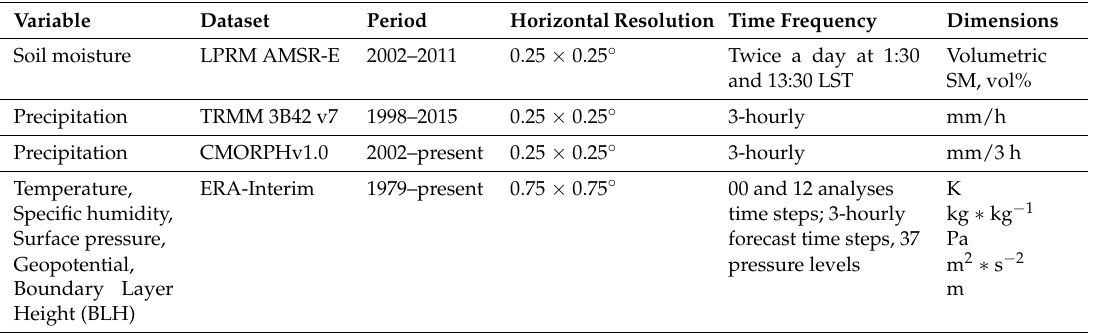
Table 1. Characteristics of datasets used in the study. The common period 2002–2011 (JJAS) and horizontal resolution of 0.25 ◦ were imposed on the products. The CMORPH precipitation data are only used for additional sensitivity tests in Appendix A. For all calculations, the volumes of precipitation parameters are scaled to mm per 3